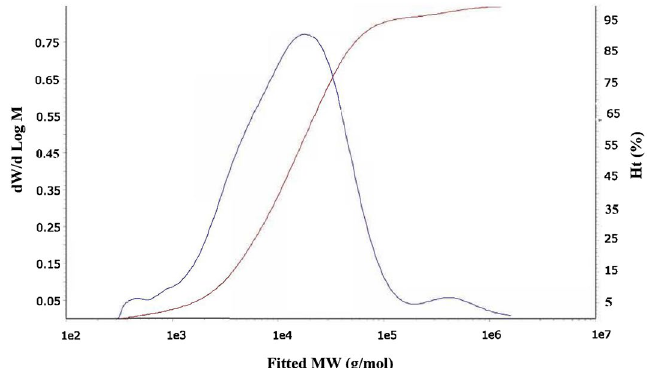
Figure 5. The gel permeation chromatography (GPC) analysis of cellulose di-acetate (Sample